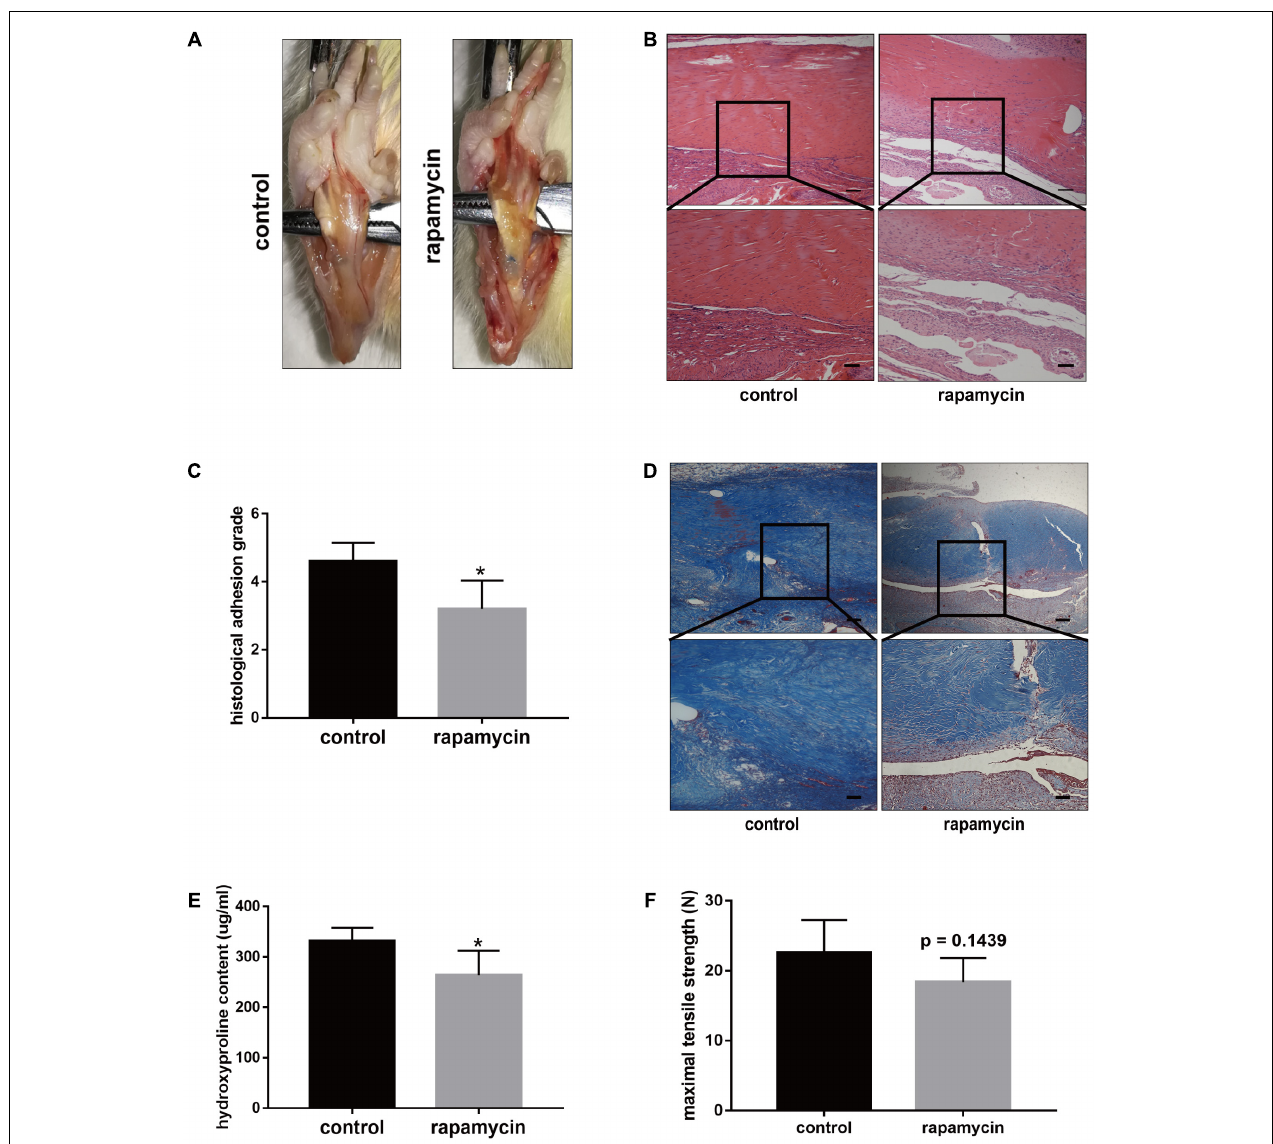
FIGURE 3 | Rapamycin administration prevents peritendinous fibrosis after tendon injury. (A) Representative images of macroscopic observation of deep flexor tendon of plantar in control and rapamycin-treated group. (B) Representative images of H&E staining of peritendinous tissues. Scale bar (upper): 250 µ m. Scale bar (lower): 100 µ m. (C) Histological evaluation of adhesion grade in different groups. (D) Representative images of masson staining for collagen in different groups. Scale bar (upper): 250 µ m. Scale bar (lower): 100 µ m. (E) Hydroxyproline (Hyp) content in different groups. (F) Maximal tensile strength (N) of deep flexor tendon in different groups. n = 5 in each group. The data are shown as the means ± SD. ∗ P < 0.05 compared with the control